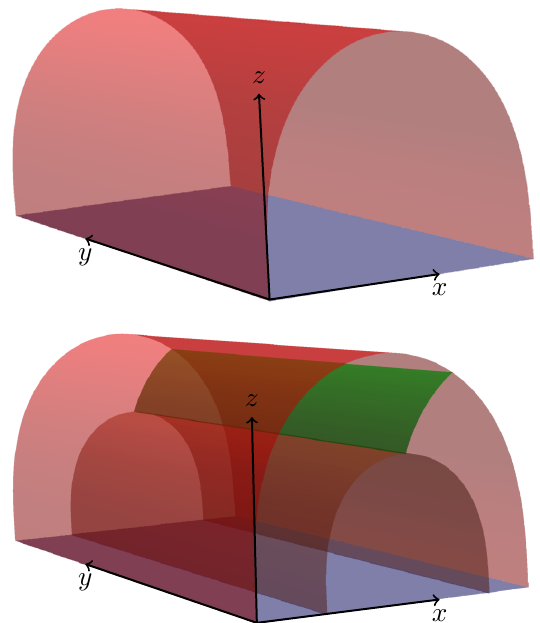
Figure 3 . The left plot: the minimum surface for a given width w . The right plot: the minimum cross-section (green surface) of the entanglement